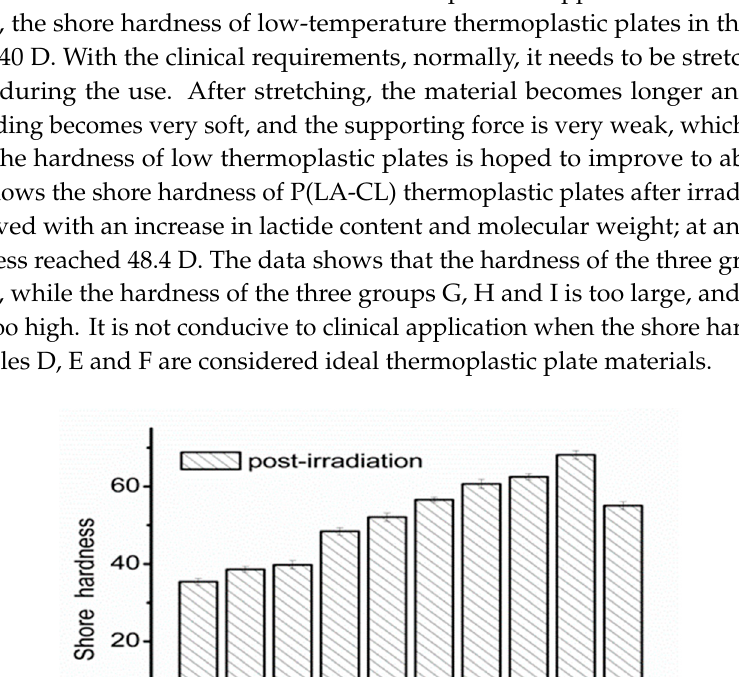
Figure 11. Shore hardness of composite materials.